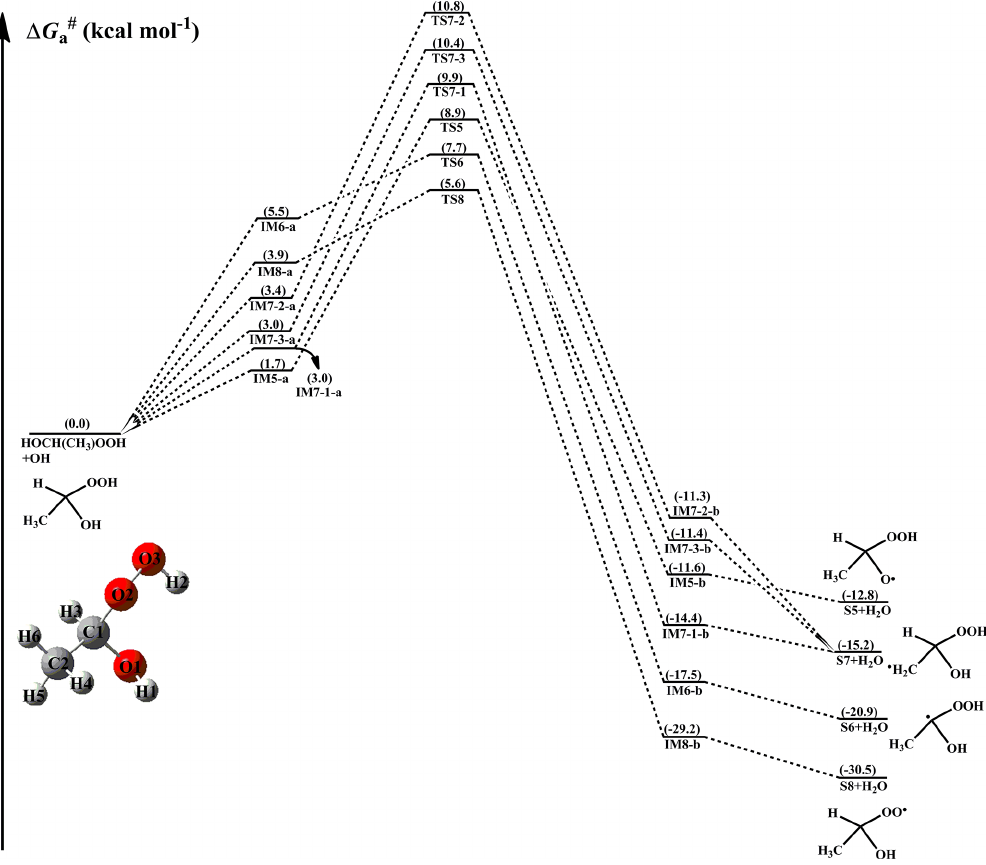
Figure 3. PES ( (cid:49)G # a ) for the OH-initiated reactions of HOCH(CH 3 )OOH from the anti- CH 3 CHOO + H 2 O reaction predicted at the M06- 2X/ma-TZVP//M06-2X/6-311+G(2df,2p) level of theory (a and b represent the pre-reactive and post-reactive